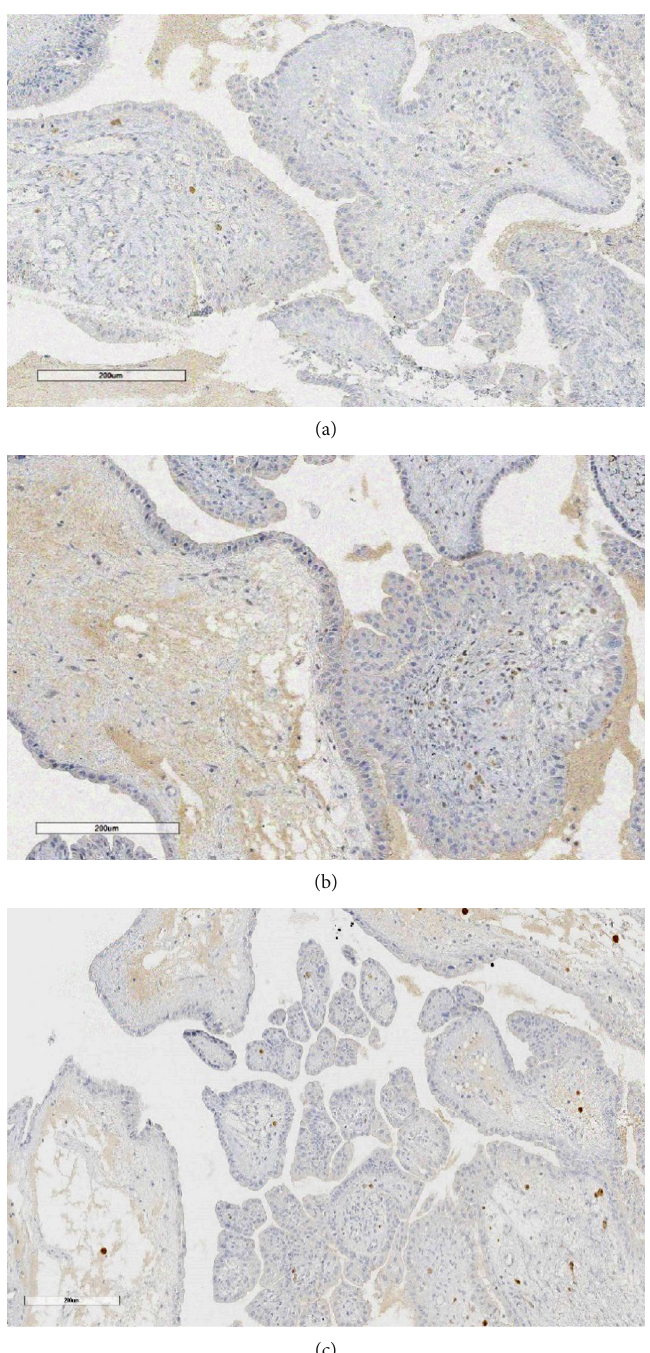
Figure 8: (a, b and c) The tumor was negative for calretinin, estrogen, and progesterone receptors,